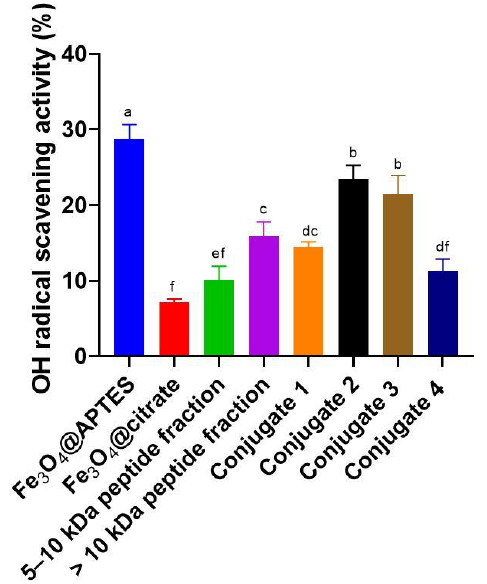
Figure 8. Average results of the OH· scavenging activities of coated magnetite (Fe 3 O 4 @APTES and Fe 3 O 4 @citrate) and of the conjugates and nonconjugated peptide fractions at 15 mg/mL: Fe 3 O 4 @citrate@ > 10 kDa (conjugate 1), Fe 3 O 4 @citrate@ 5–10 kDa (conjugate 2), Fe 3 O 4 @APTES@ > 10 kDa (conjugate 3), Fe 3 O 4 @APTES@ 5–10 kDa (conjugate 4), and nonconju- gated peptide fractions (>10 kDa and 5–10 kDa peptide fractions). The determinations were carried out in triplicate. The results are expressed as the means ± standard deviation. Different letters indicate statistical differences between the samples ( p ≤